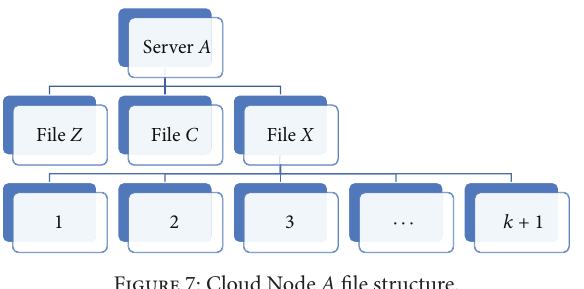
Figure 7: Cloud Node A file structure.